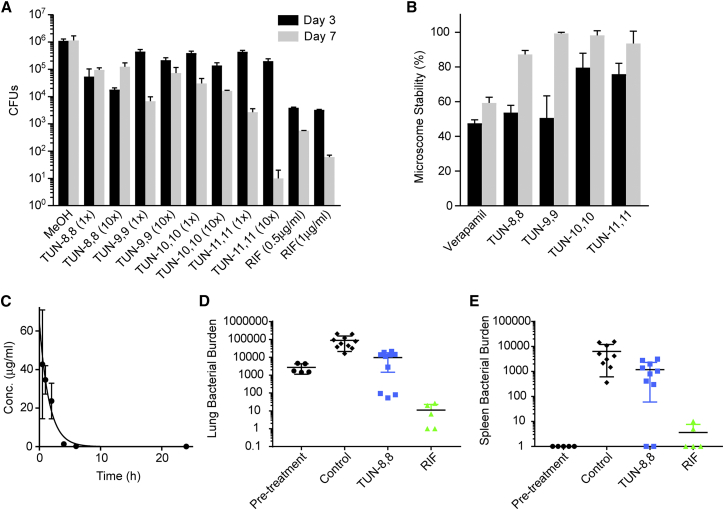
Tunicamycin Analogues Eradicate Mtb during Host Pathogenesis(A) Efficacy of tunicamycin analogues in macrophages. Infected J774A.1 macrophages were treated with compounds (1x and 10x MIC) for 3 or 7 days after which bacterial burdens were counted (n=3).(B) Microsomal stability of the tunicamycin analogues in human (black) and mice (grey) liver microsomes assessed over a period of 30 mins (n=3).(C) Mouse blood serum TUN-8,8 concentrations after a single intra-peritoneal injection of 30 mg/kg (n=5).(D) Efficacy of TUN-8,8 in reducing lung bacterial burdens in Mtb-infected mice after 2 weeks of treatment.(E) Efficacy of TUN-8,8 in reducing spleen bacterial burdens in Mtb-infected mice following 2 weeks of treatment. Unpaired t test for the TUN-8,8 and vehicle control group p value of 0.0017 in lungs and 0.01 in spleens.For all panels (A–C), data presented are means ± SD. For panels (D) and (E), the individual median calculated for each individual mouse organ with standard error of the mean calculated for each group is shown.